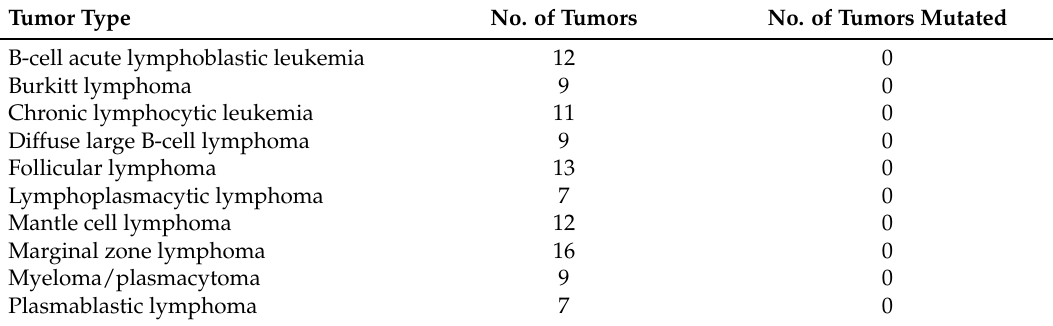
Table 1. Samples tested for telomerase reverse transcriptase ( TERT ) promoter mutations 1 .